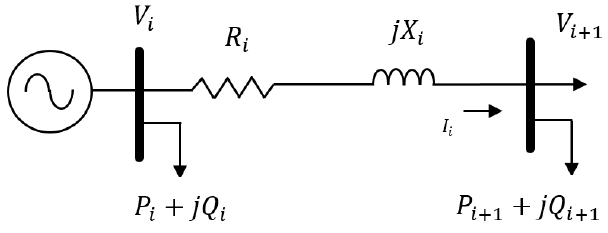
Figure 12. Single-line technique diagram of DNS feeder of [75].